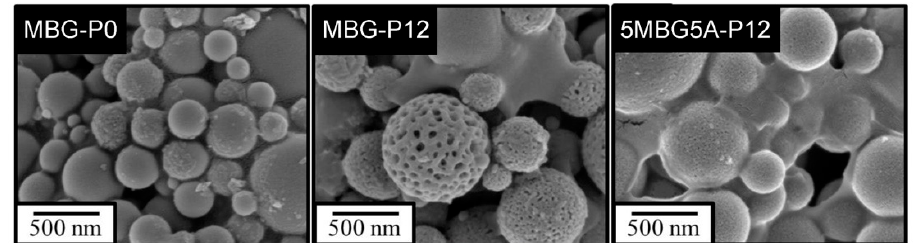
Figure 11. The FE-SEM images of MBG-P0, MBG-P12, and 7MBG5A-P12 immersed in SBF for 72 h.